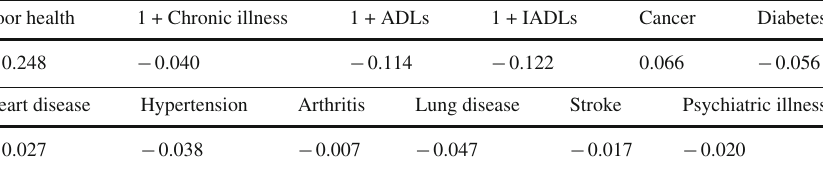
Table 3 Correlation coefficients of years of education and health outcomes Poor health 1 + Chronic illness 1 + ADLs 1 + IADLs Cancer Diabetes − 0.248 − 0.040 − 0.114 − 0.122 0.066 − 0.056 Heart disease Hypertension Arthritis Lung disease Stroke Psychiatric illness − 0.027 −